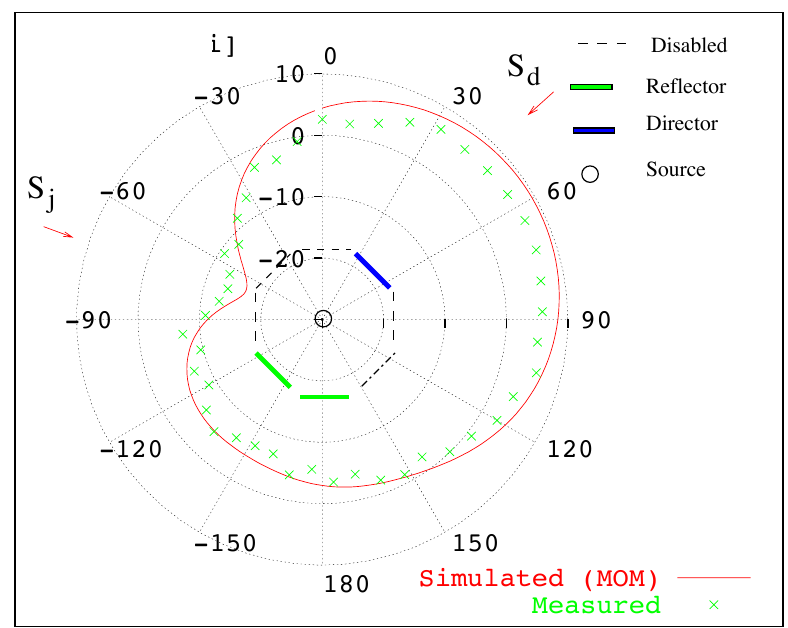
Figure 15. Experimental assessment. Single interference signal, tracking example, impinging direction ( θ i = 90, φ i = 70). Beam-pattern ( θ = 90 )